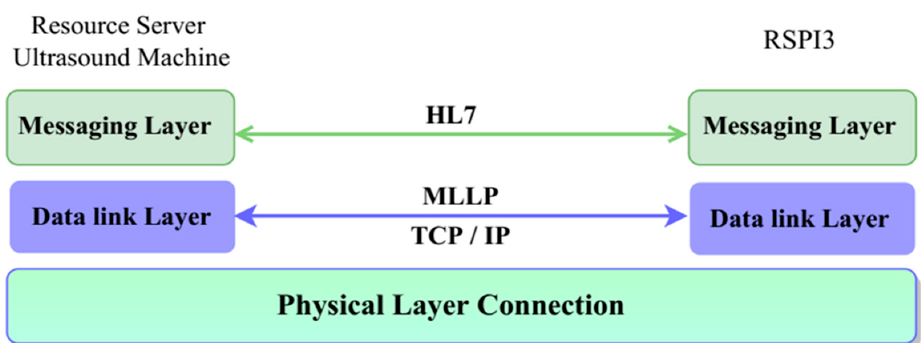
Figure 5. HL7 protocol layer-based connection.